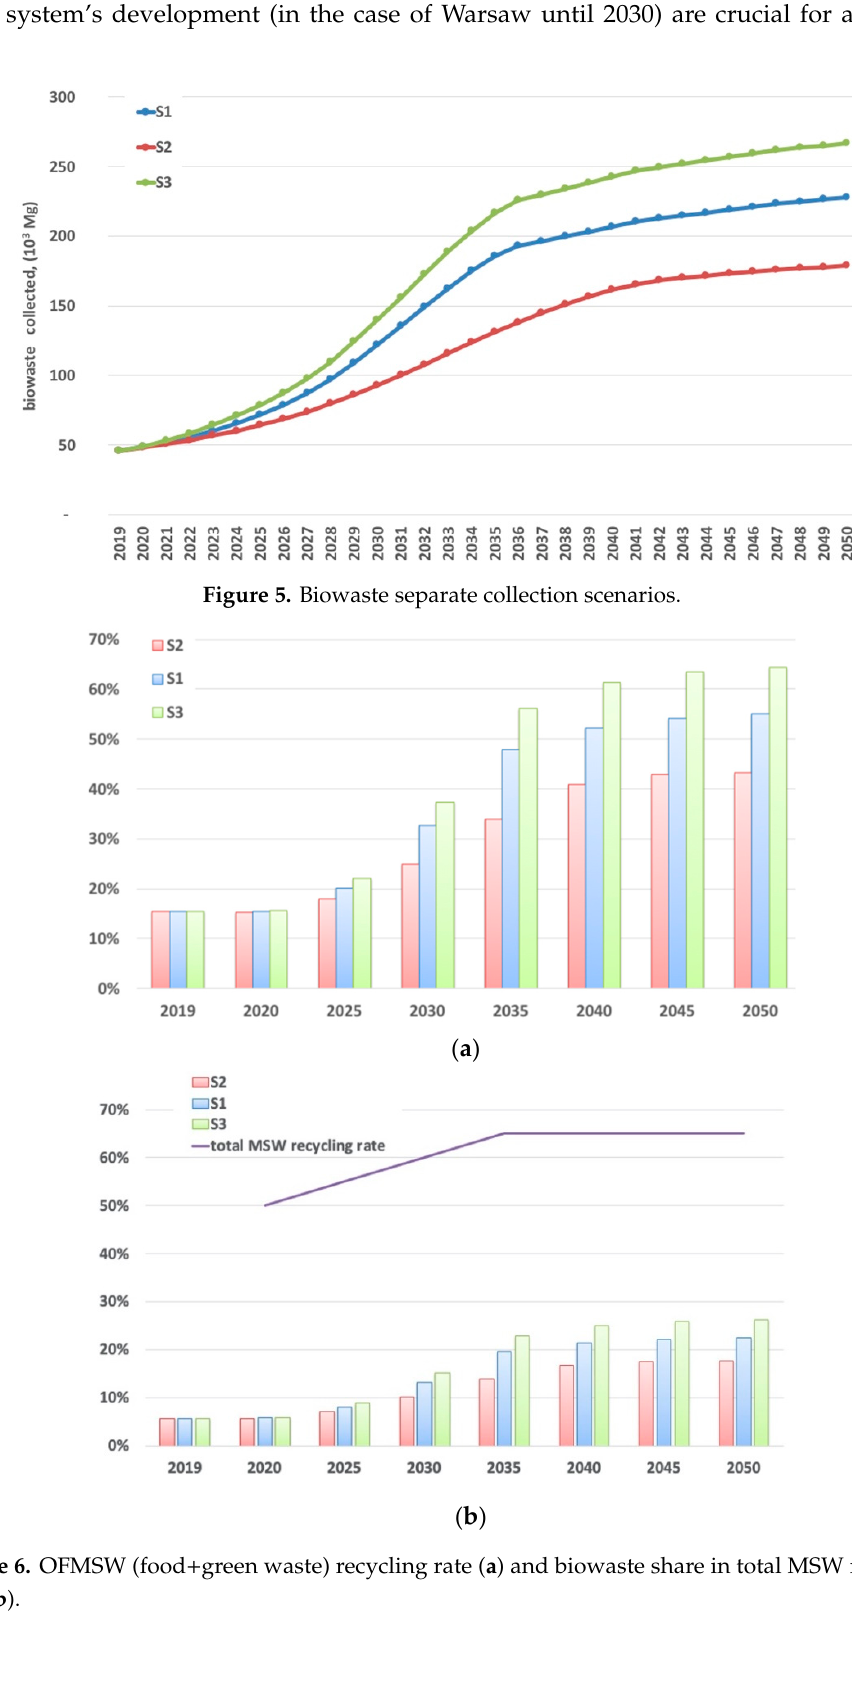
Figure 6. OFMSW (food+green waste) recycling rate ( a ) and biowaste share in total MSW recycling rate ( b ).